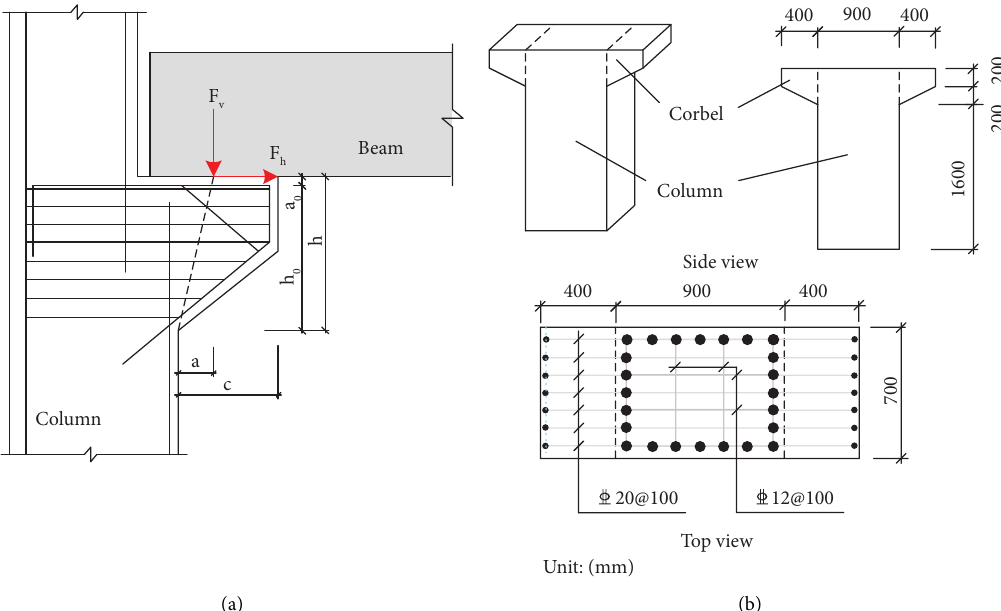
Figure 3: Schematic diagram of corbel column: (a) schematic diagram of corbel and (b) corbel shape of precast lower